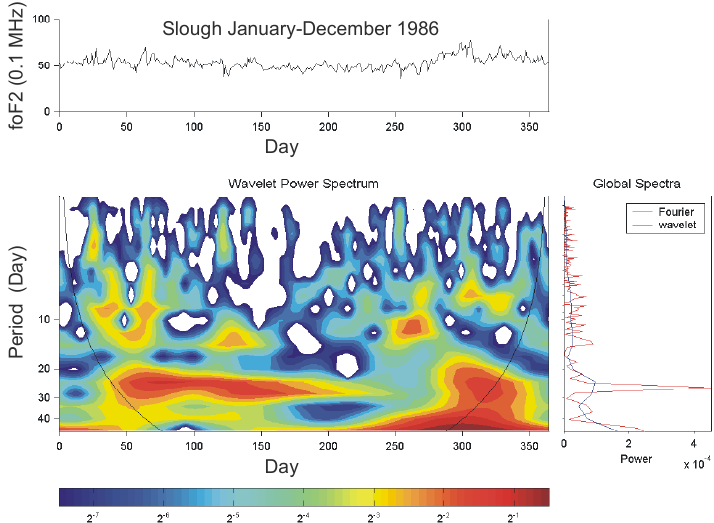
Fig. 6. Planetary wave activity inferred from fo F2 for Slough, January–December 1986, Morlet wavelet transform. Top panel, time series of raw fo F2 data. Bottom left panel, wavelet transform power spectrum of the planetary wave activity changing by colour from white and black-blue (minimum values) through green to red and black-red (maximum values). Power spectrum is normalized to 1. Bottom right panel - global (over 365 days) Morlet wavelet and Fourier spectrum; horizontal axis - power; vertical axis – period of oscillations in